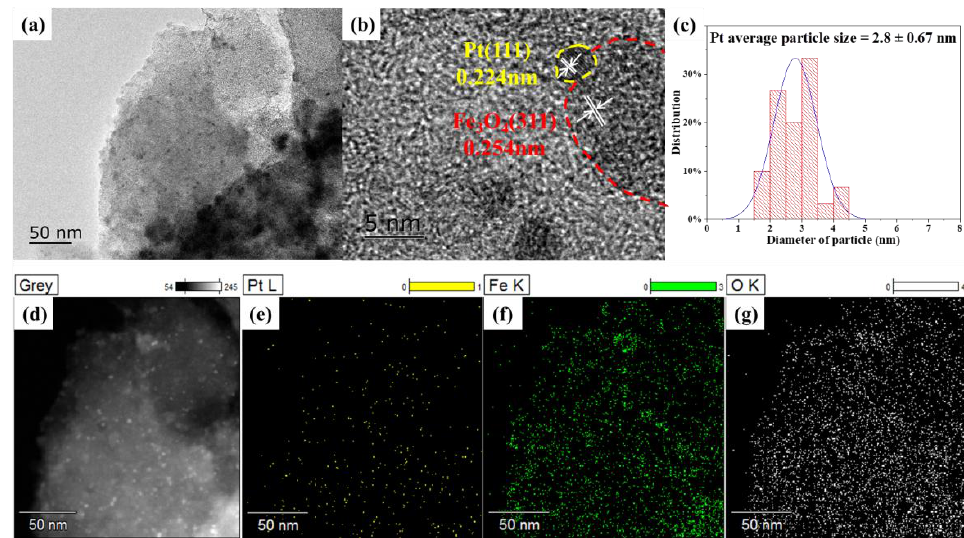
Figure 2. ( a , b ) TEM images with low and high magnification, respectively; ( c ) particle size distribution histogram; ( d – g ) EDS mapping profiles for ( e ) Pt, ( f ) Fe, and ( g ) O of 0.5% Pt-2% FeO x /AC catalyst.